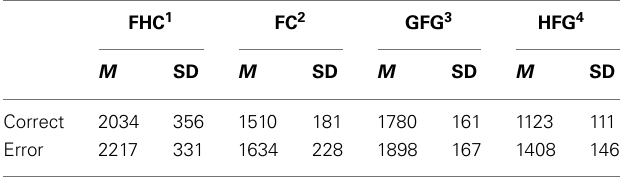
Table 2 |Average judgment times for finger gnosia correct and error conditions as a function of subgroup